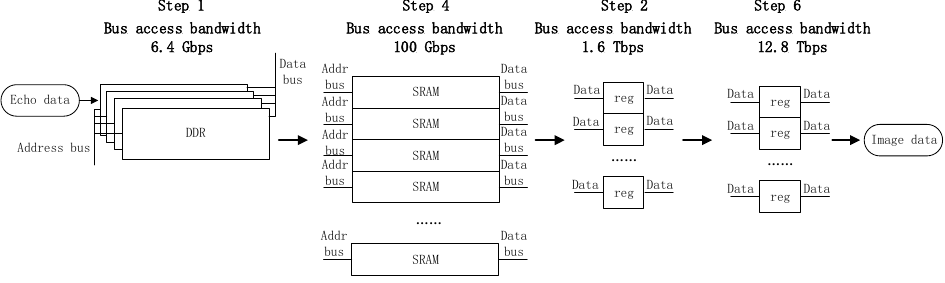
Figure 13. Distributed storage schematic.